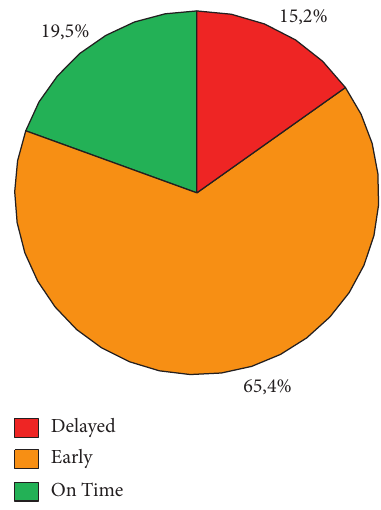
Figure 3: Pie chart of departure